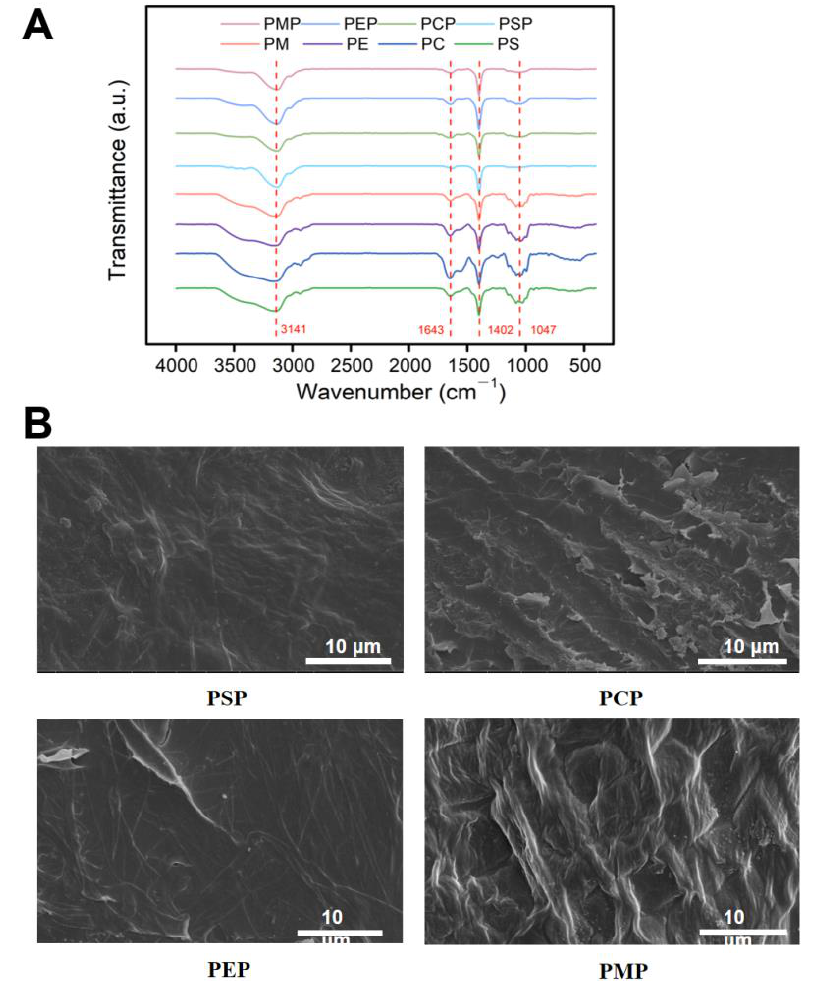
Figure 4. Chemical structure and micromorphology of four P. eryngii papery food items. ( A ) The FT-IR spectra of raw materials and P. eryngii papery foods. ( B ) SEM images of the surfaces of four P. eryngii papery foods (PSP, PCP, PEP, and PMP). The magnification level was 5000×.